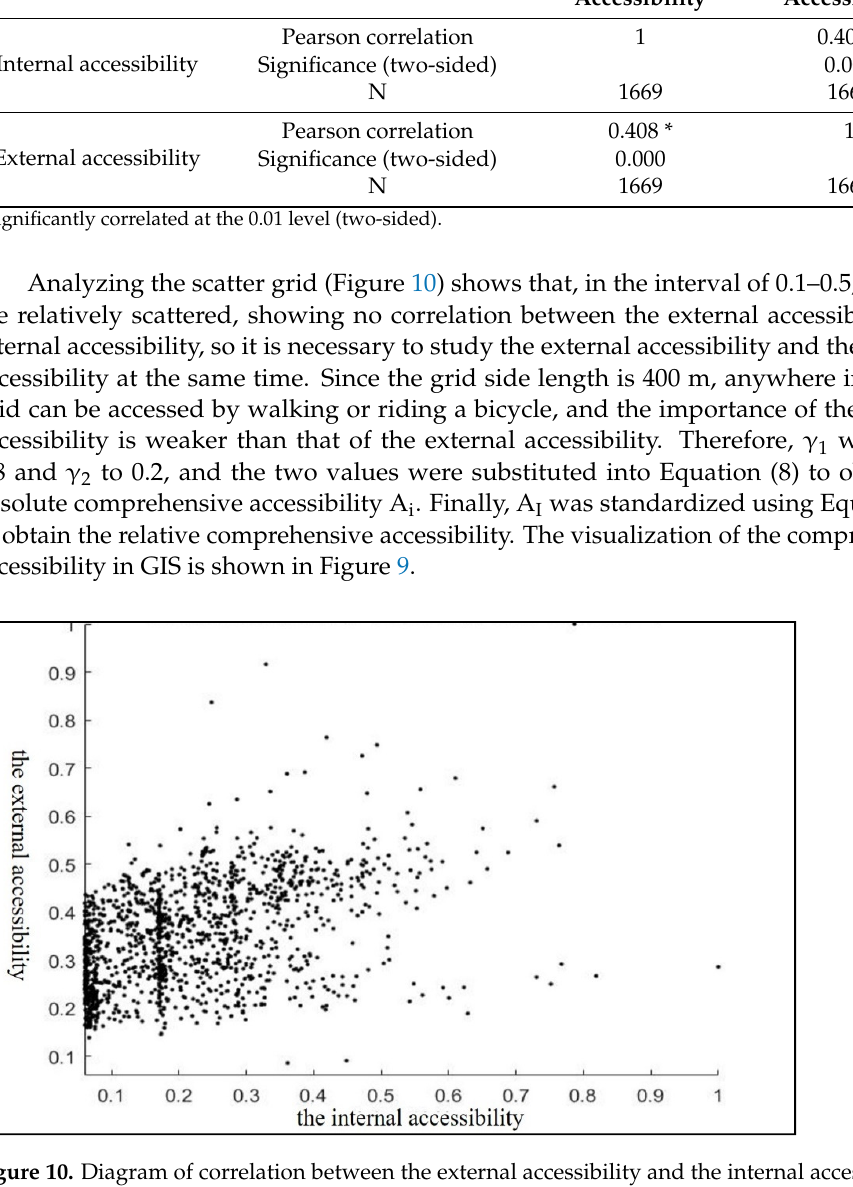
Table 5. The Pearson correlation from the analysis is 0.408, while the two ‐ sided signifi ‐ cance is 0.000 (<0.01), indicating that the internal accessibility and the external accessibility are positively correlated at the 0.01 level. This is consistent with objective knowledge. Table 5. Correlation analysis of internal accessibility and external accessibility. Internal Accessibility